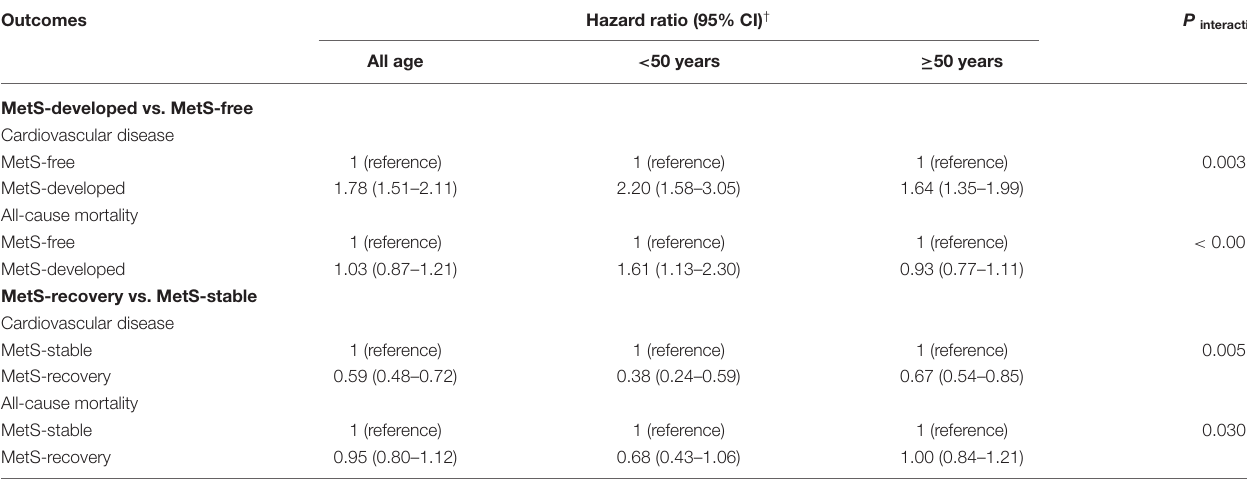
TABLE 2 | Hazard ratios and 95%CIs of the cardiovascular disease and all-cause mortality in MetS-developed and MetS-recovery groups according to the age of MetS status change. Outcomes